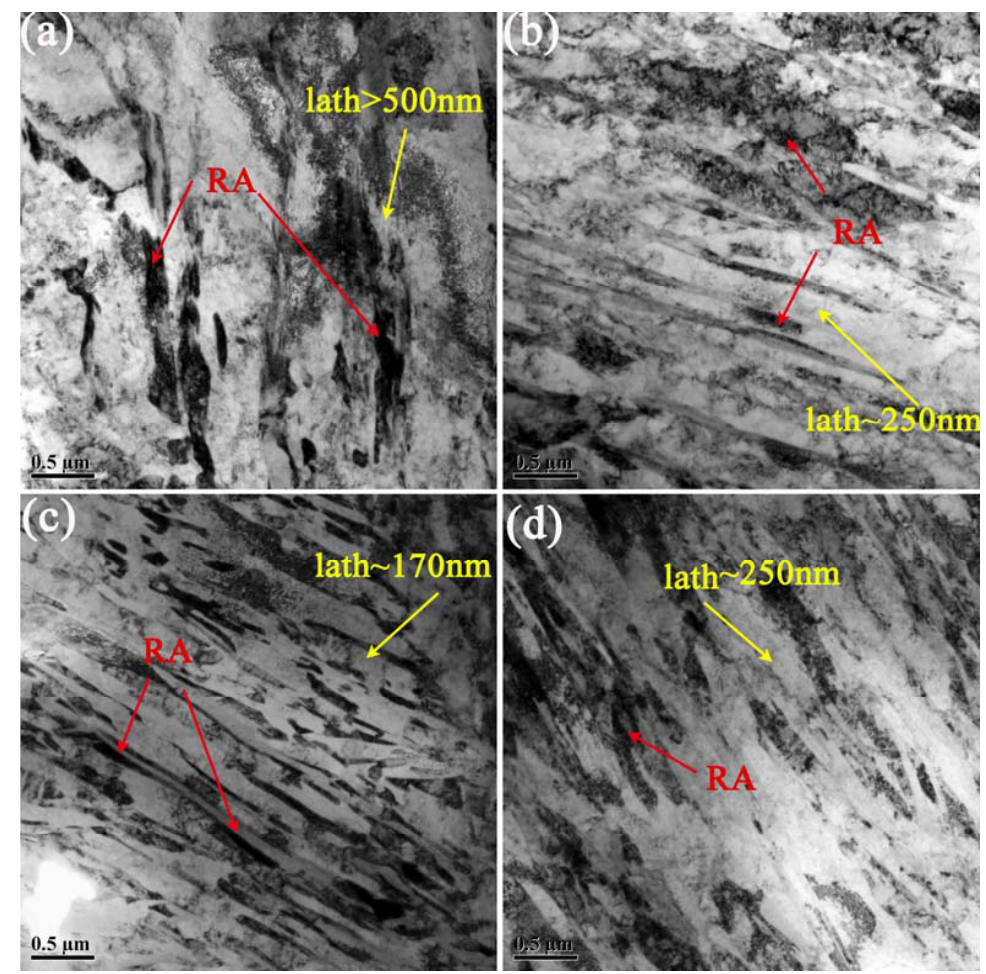
Figure 5. TEM bright-field of deposited metals. ( a ) Cu 0.62, ( b ) Cu 1.38, ( c ) Cu 1.79, ( d ) Cu 2.32. The α‐ Fe of deposited metals is lath structure, the black film area is RA.